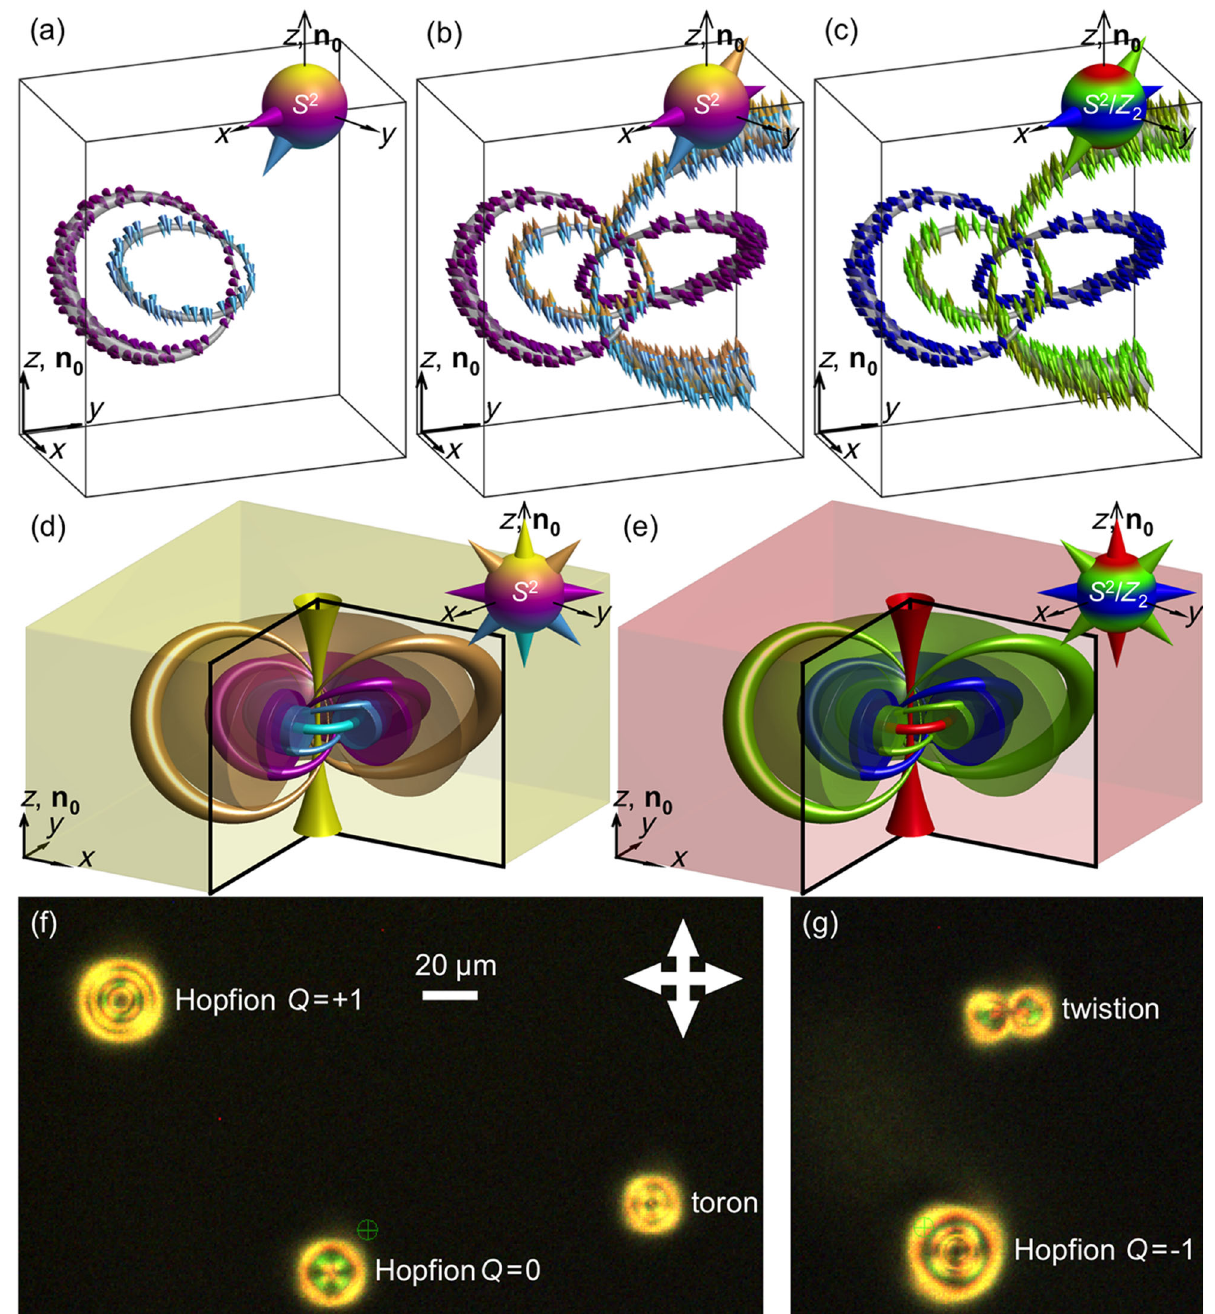
FIG. 1. 3D topological solitons in chiral nematic LCs. (a) – (c) Examples of closed-loop preimages of 3D topological solitons corresponding to (a) the two distinct points on S 2 (shown using cones) for vectorized n ð r Þ and (b), (c) two distinct points on S 2 =Z 2 and nonpolar n ð r Þ , with the ground-state manifold S 2 =Z 2 depicted as a sphere with diametrically opposite points identified through coloring and making the n and − n orientations nondistinguishable. Note that the diametrically opposite points in (b) appear simultaneously, so that the two points on S 2 =Z 2 are four points on S 2 for the vectorized director field. (d), (e) Illustrations of Hopf maps of closed-loop preimages of 3D topological solitons embedded in a uniform far-field n 0 onto the (d) S 2 ground-state manifold for vectorized n ð r Þ and (e) S 2 =Z 2 order parameter space of the LC for nonpolar n ð r Þ . The schematics show linking of the hopfion ’ s circlelike preimages that reside on nested tori in the sample ’ s 3D space and correspond to color-coded points (cones) on S 2 or S 2 =Z 2 . (f),(g) Polarizing optical micrographs of the studied localized field configurations coexisting within the same LC sample. The images are obtained between crossed polarizers (white double arrows). The green circles with crosses visible in the micrographs show locations of “ invisible ” infrared laser traps used to manipulate the naturally occurring localized field configurations. The micrographs are obtained for a 5CB-based partially polymerizable nematic LC mixture with chiral additive cholesteryl pelargonate, d ¼ 10 μ m, and d=p ∼ 1 .